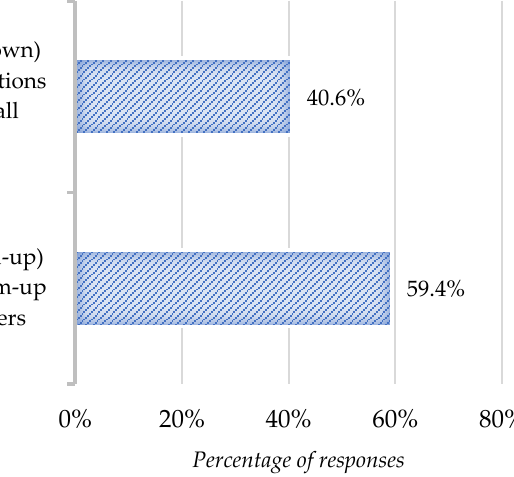
Figure 5. Distribution of answers to the question: ‘ How should such open innovation solutions be implemented? ’ Source: Own study.